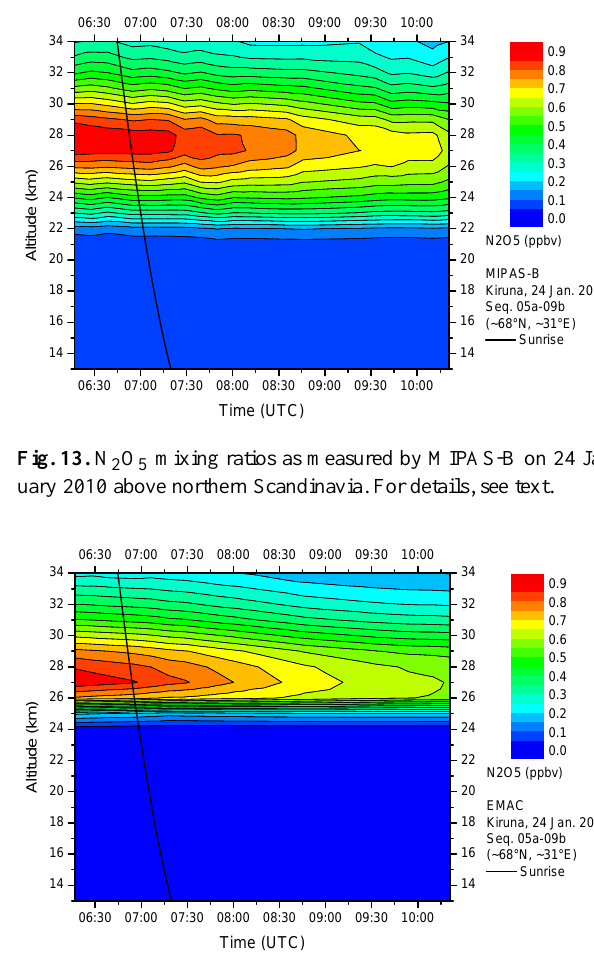
Fig. 12. Top panel: Measured and modelled temporal behaviour of NO 2 at 33 km. A temporal delay in the observed NO 2 decrease after sunrise is clearly visible. Middle panel: NO 2 photolysis frequencies ( J NO2 ) as calculated with the TUV (version 5.0) radiation model (bluish curves lie close together) along with photolysis frequencies from EMAC and MIPAS-B (estimated assuming steady state, see text) are shown for comparison. While tropospheric clouds have no significant influence on the photolysis rate, PSC strongly affect J NO2 . Bottom panel: Ratio of the direct to total fraction of the NO 2 photolysis frequency as calculated by TUV. Around sunrise, the diffuse radiation dominates the NO 2 photolysis rate. Annotation as per Fig. 6.